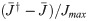
(A) Relative differences (i.e. before versus after spike-triggered stimulation) for mean synaptic strengths (J¯†-J¯)/Jmax as a function of stimulation delay d† and correlation peak width σ (as in Fig 4D). Subplots show outcome for all combinations of pre- and post-synaptic groups a, b, c, for 2.5 ≤ d† ≤ 12.5 (ms) and 1 ≤ σ ≤ 50 (ms). Star indicates parameter choice for panel B. (B) Bar plots of mean synaptic strength relative difference (J¯†-J¯)/Jmax for all combinations of pre- and post-synaptic groups, with d† = 5 ms and σ = 17 ms. Top: normal network (values marked by a star in panel A). Middle: network where b-to-c synapses are inactivated (Jcb ≡ 0). Bottom: network where a-to-c synapses are inactivated (Jca ≡ 0). Red crosses indicate the artificially inactivated synapses and red arrows show the most drastic change due to inactivation, in comparison to the normal network (top).